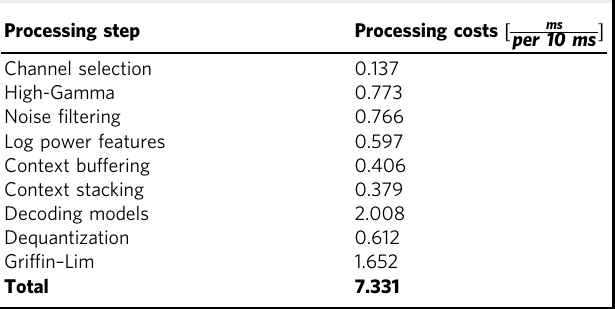
Table 1 Mean processing costs for each node in the decoding